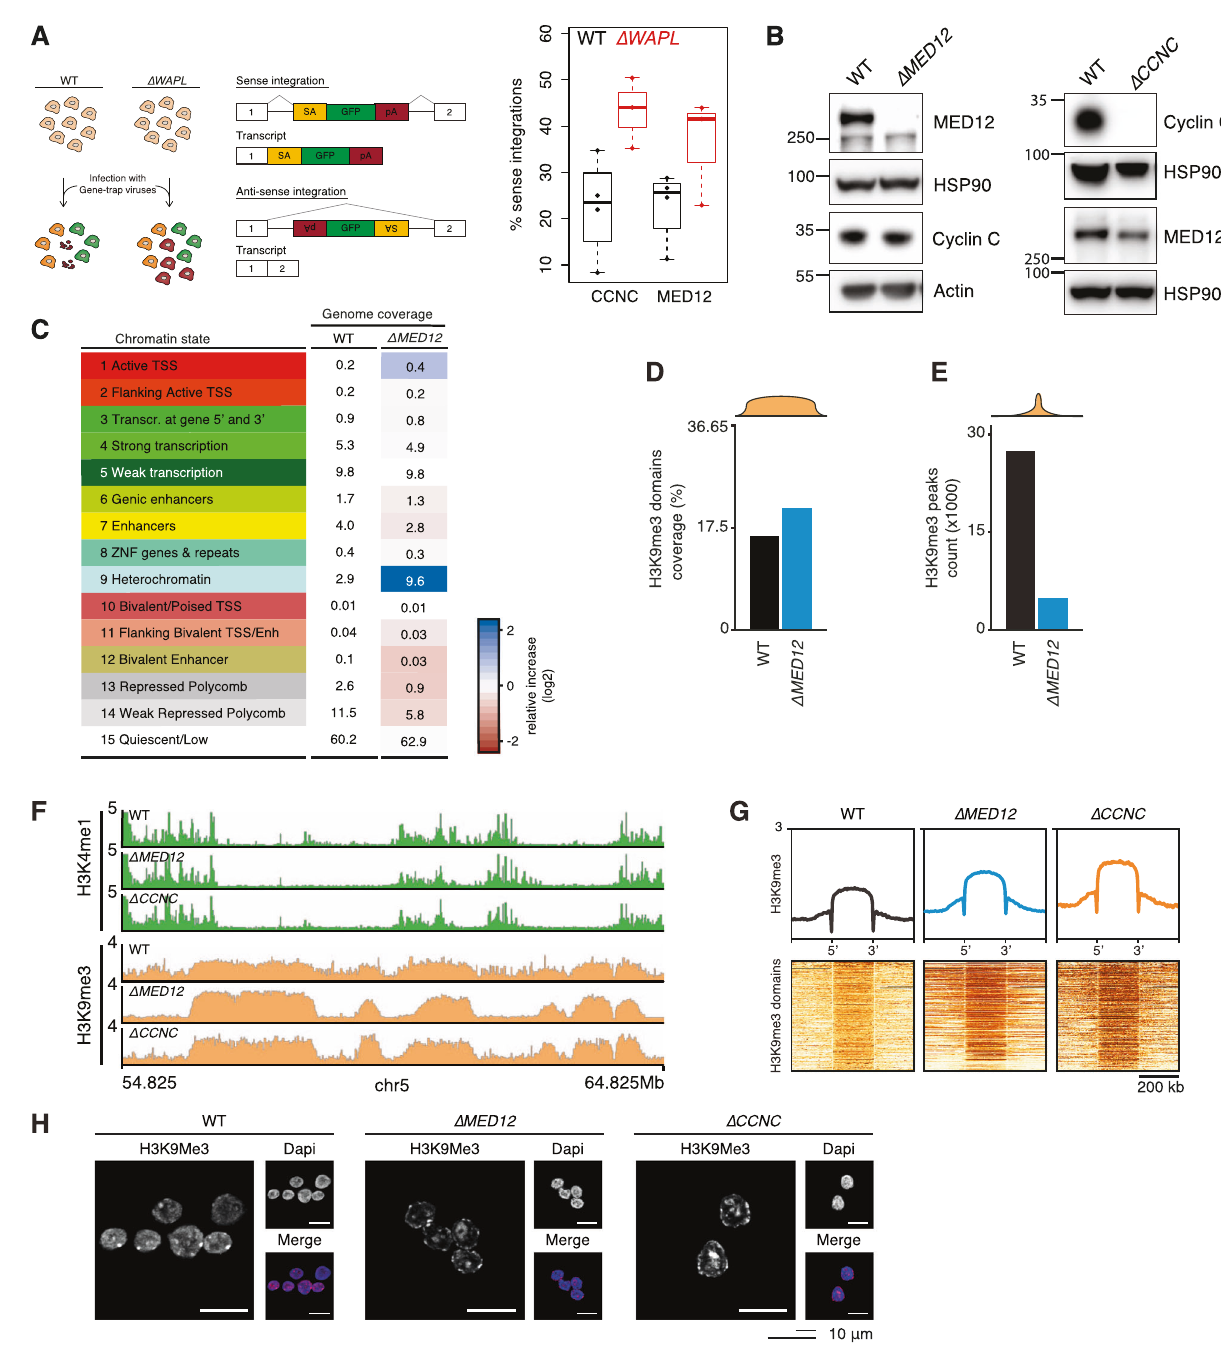
Fig. 2 Mediator-CDK subunits restrict heterochromatin. A Left panel shows schematic explanation of the haploid genetic gene trap assay. Sense integrations with respect to a protein coding gene result in truncating deletion. Anti-sense integrations are largely inconsequential and serve as a control for accessibility of the gene. Right panel shows percentage of sense integrations (over a total of sense and anti-sense) shown for WT and Δ WAPL cells for the Mediator subunits Cyclin-C (CCNC) and MED12. Boxplot shows the result of n = 3 haploid genetic gene trap assays for WT and Δ WAPL cells. Boxes indicate the interquartile range (IQR) of the data (25 – 75%) and box center line indicates the median. Whiskers extend to the minimum or maximum value that lies no further than 1.5 times the IQR from the bottom or top of the box, respectively. B Western blot analysis con fi rming knock-out of MED12 and Cyclin-C. HSP90 and actin represent loading controls for MED12 and Cyclin-C panels directly above. Representative images are shown from experiments that have been performed twice. C ChromHMM analysis segmenting the genome in 15 chromatin states shown for WT and MED12 cells. Table shows the percentage of genome coverage. Red/blue color scale indicates the relative increase or decrease in Δ MED12 compared to the WT cells. D Barplot showing the coverage of H3K9me3 domains over the genome and ( E ) the absolute number of H3K9me3 peaks. F Example region showing the H3K4me1 (green) and H3K9me3 (orange) ChIPseq pro fi les in WT, Δ MED12 and Δ CCNC cells. G Aggregate plots showing the average H3K9me3 signal over all the H3K9me3 domains for WT and mutant cells. Heatmaps show the signal in and around individual domains. H Immuno fl uorescence analysis of H3K9me3 levels in WT, Δ MED12 and Δ CCNC cells. Representative images are shown from experiments that have been performed twice (see Supplementary Fig. 2e).